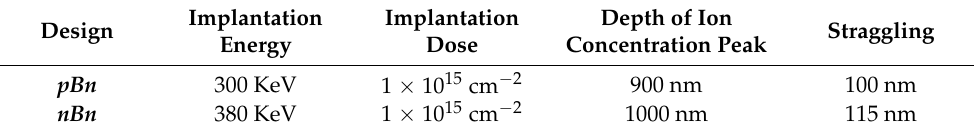
Table 1. Optimized implantation parameters for the pBn and nBn designs.